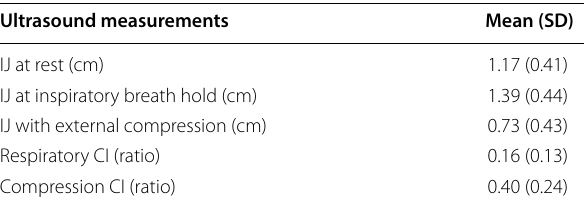
Table 2 Bedside ultrasound measurements of internal jugular